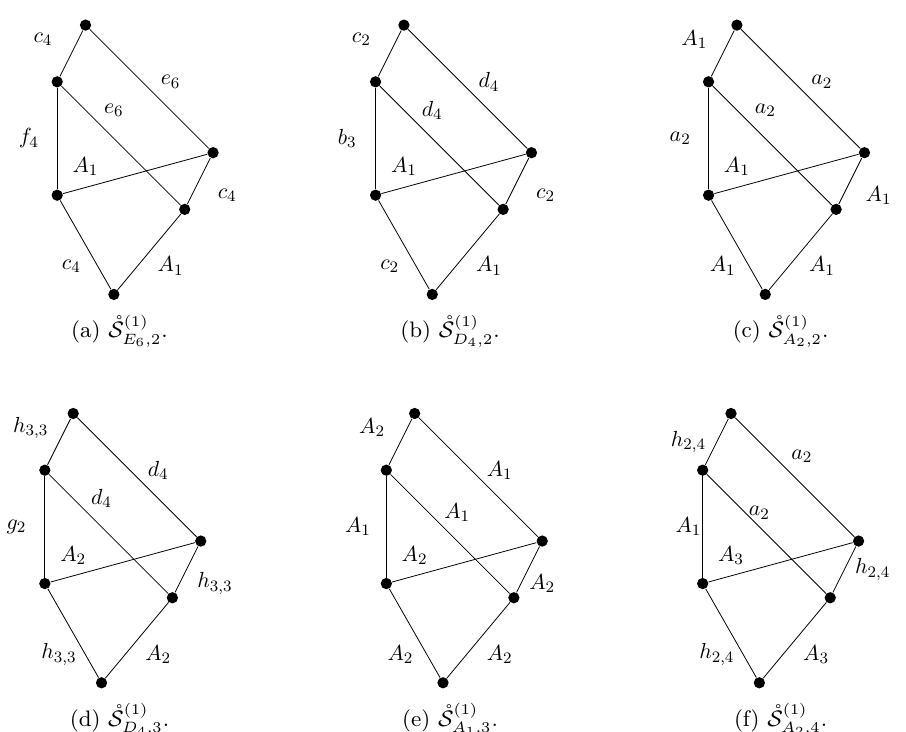
˚ theories. These are subdiagrams of the right part of S (1) G,‘